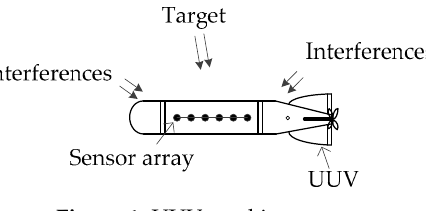
Figure 1. UUV working status.